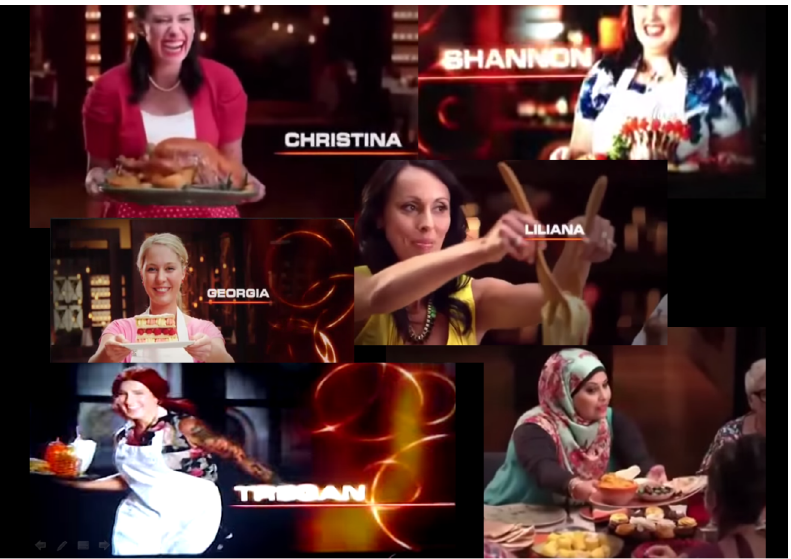
Figure 2. Female contestants presenting food to the camera or serving other contestants in introduction segments